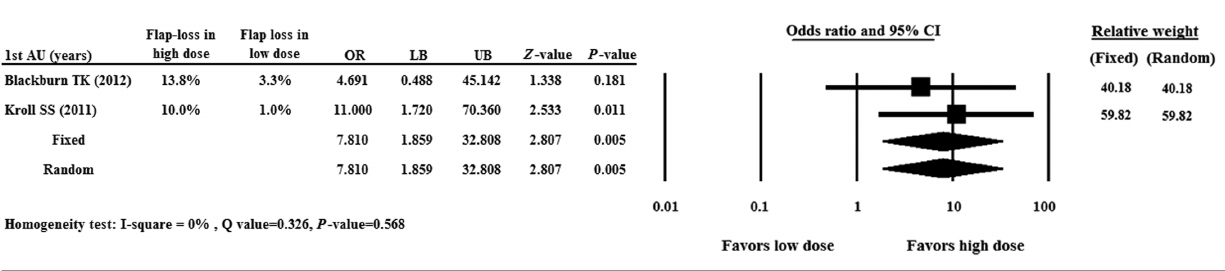
Figure 3. Forest plot showing odds ratio (OR) offlap lossbetween high and low doses of dalteparin or heparin. Data are presented as OR with the 95% confidence interval (CI). A value of p , 0.05 indicates a statistically significant difference.